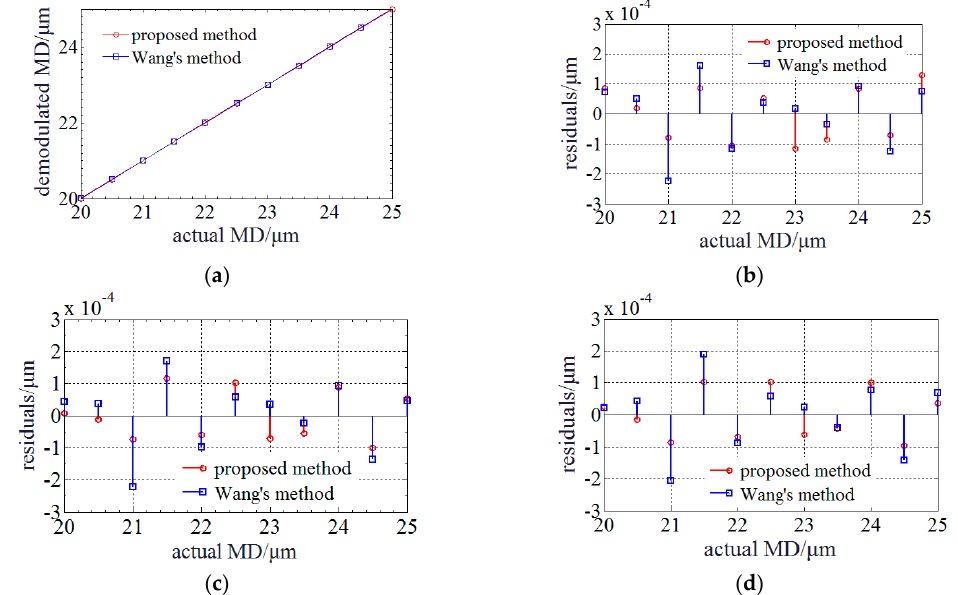
Figure 6. Relationship and fitting residuals between the demodulated and actual MD when BLS is in measured profile: ( a ) Relationship between the demodulated and actual MD; ( b ) Linear polynomial fitting residuals; ( c ) Quadratic polynomial fitting residuals; ( d ) Cubic polynomial fitting residuals.